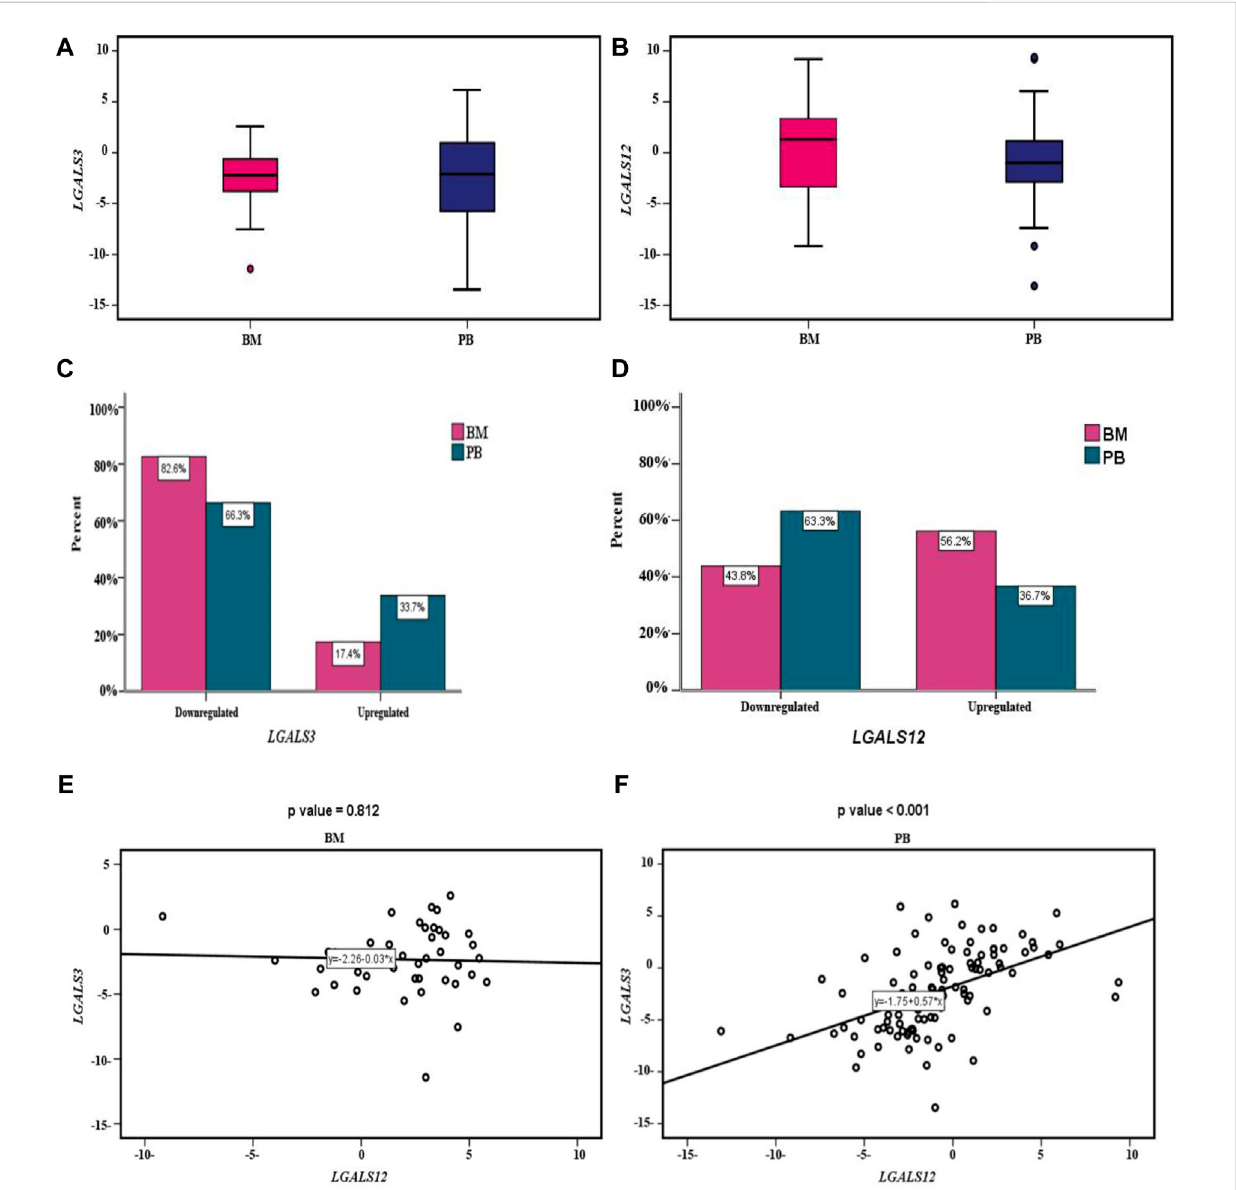
FIGURE 2 LGALS3 & 12 expressions in AML patients: (A) Box plot showing differential expression of the LGALS3 gene in PB & BM; the X-axis represents the LGALS3 geneandtheY-axisshowsBMandPBcohorts. (B) Boxplotshowingdifferentialexpressionofthe LGALS12 geneinPB&BM;theX-axisrepresents the LGALS12 gene and the Y-axis shows BM and PB cohorts. (C) Cluster bar showing association between the LGALS3 gene expression in PB & BM; the X-axisrepresentsthepercentandtheY-axisshowsthe LGALS3 geneexpressioninBMandPBcohorts. (D) Clusterbarshowingassociationbetween LGALS12 gene expression in PB & BM; the X-axis represents the percent and the Y-axis shows the LGALS12 gene expression in BM and PB cohorts. (E) Scatter plot showing the correlation between LGALS3 & 12 genes expression within BM. The X-axis represents the LGALS3 gene expressionand the Y-axis shows the LGALS12 gene expression. (F) Scatter plot showing the correlation between LGALS3 & 12 genes expression within PB; the X-axis represents the LGALS3 gene expression and the Y-axis shows the LGALS12 gene expression. Abbreviations: BM (Bone marrow); PB (Peripheral